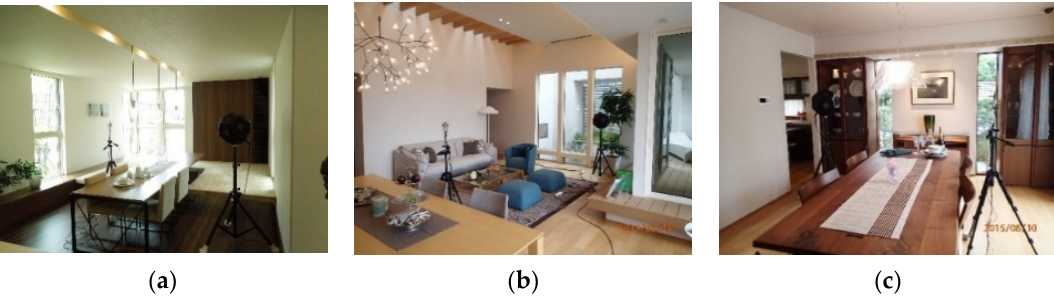
Figure 9. Measurement of impulse response in the three LD rooms: houses ( a ) A, ( b ) B, and ( c ) C.